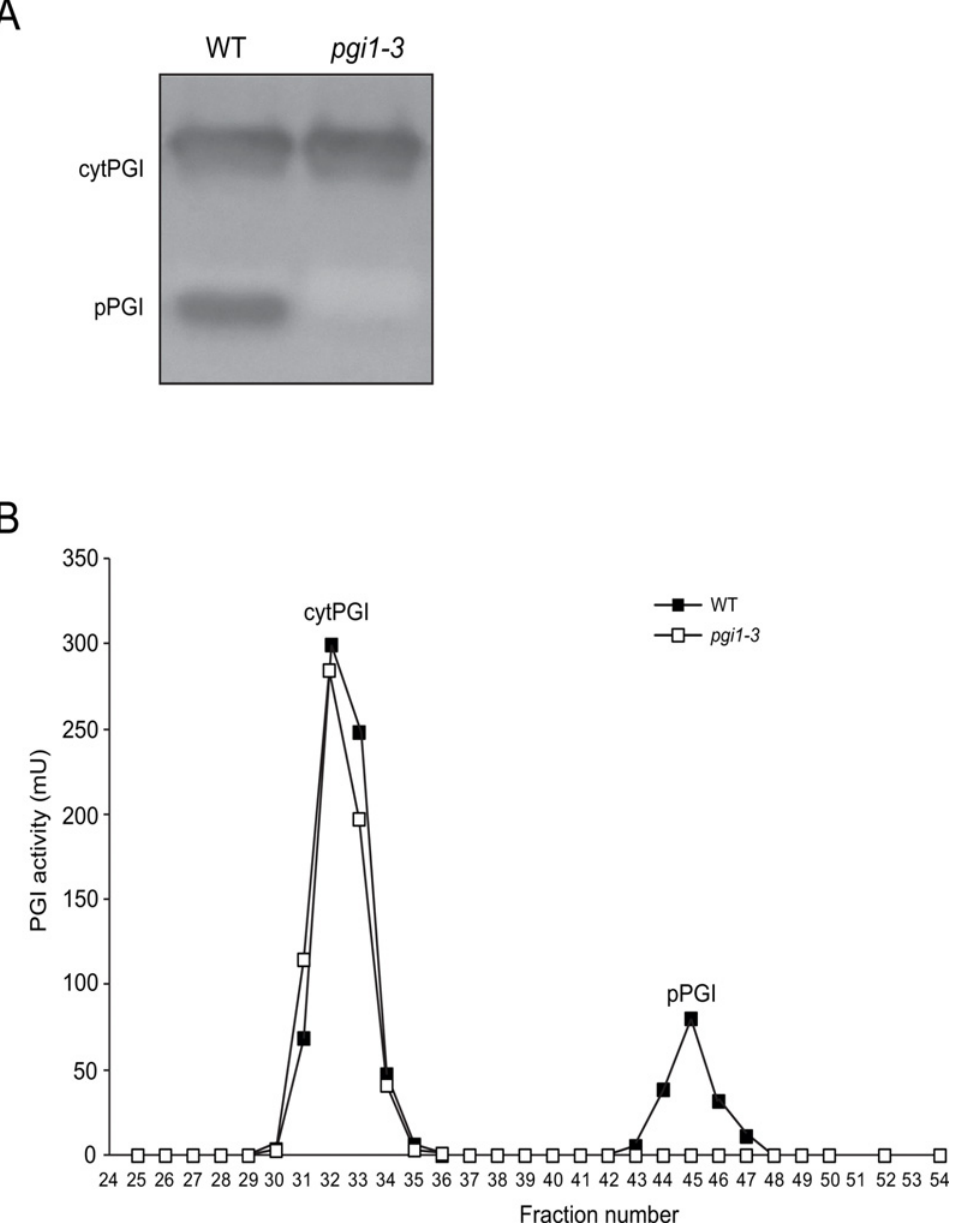
Fig 3. pgi1 – 3 leaves lack pPGI activity. (A) PGI zymogram of proteins extracted from WT (L er ) and pgi1 – 3 leaves. (B) Q-sepharose chromatography profile of PGI activity in WT and pgi1 – 3 leaves. In “ B ” , loaded WT extract contained 850 mU of total PGI activity, whereas pgi1 – 3 extract loaded on the column contained 650 mU of PGI